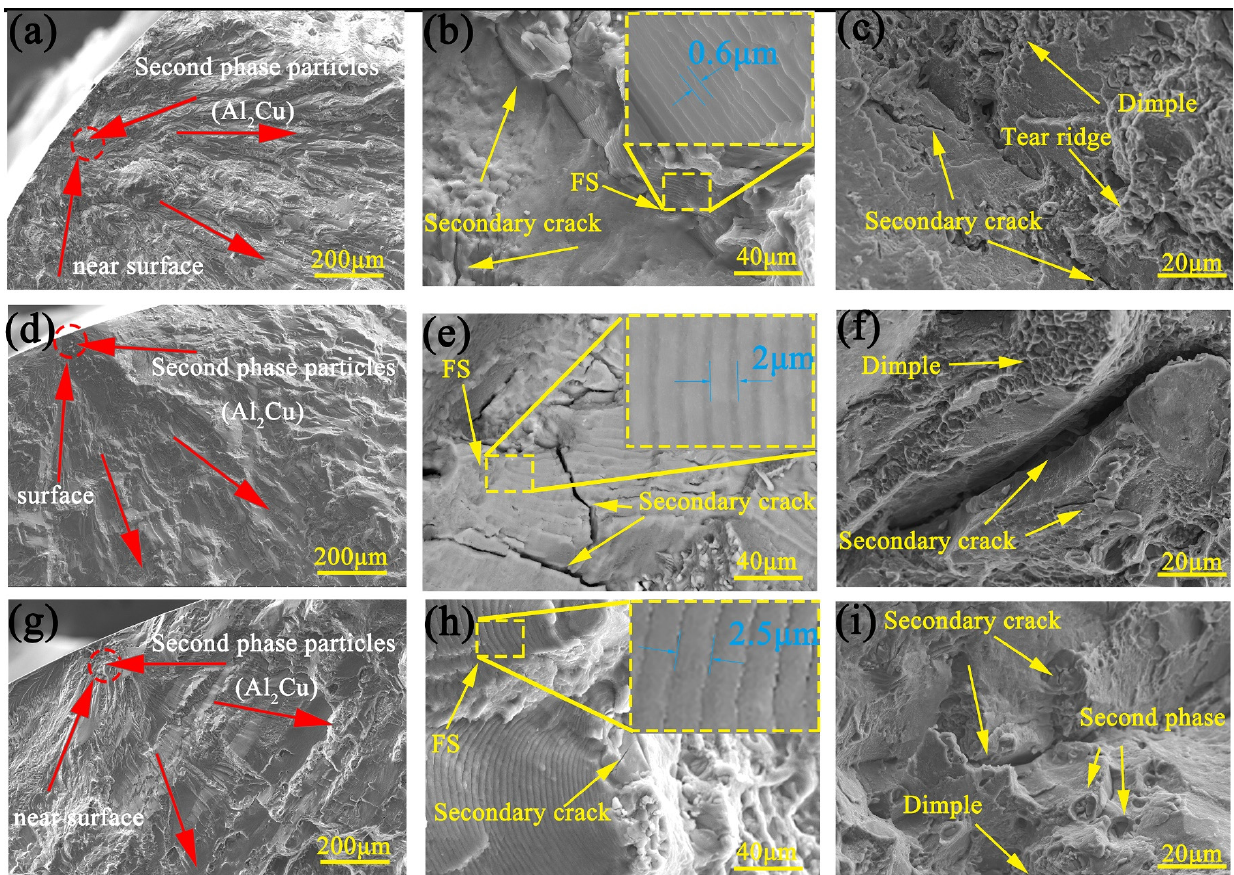
Figure 12. SEM images of ( a , d , g ) FCI, ( b , e , h ) FCG and ( c , f , i ) FF region at a total strain amplitude of 0.5% for ED ( a – c ), 45° ( d – f ) and RD ( g – i ) specimens.